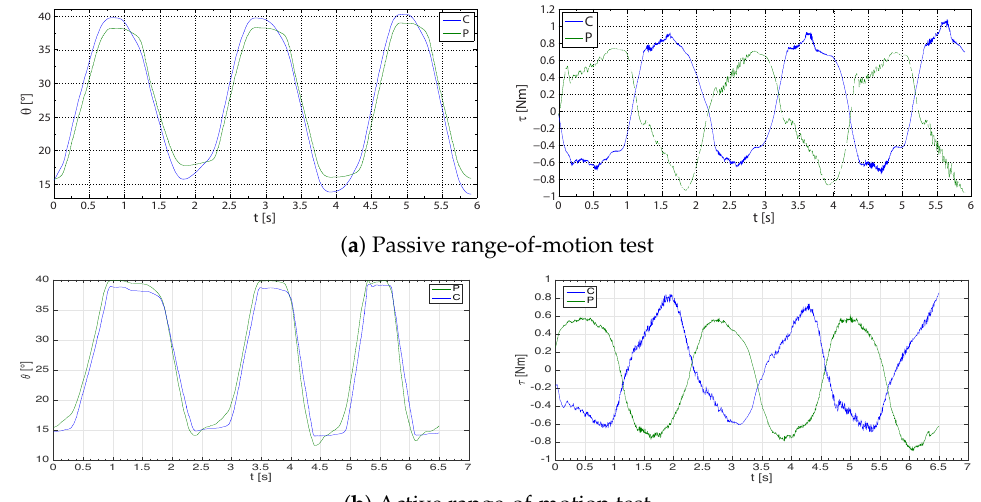
Figure 11. Example of position ( left ) and torque ( right ) tracking performance for the position-force (P-F) two-channel controller operating in contact with a healthy subject during a trial of a passive range-of motion test ( top ) and an active range-of motion test ( bottom ), respectively. τ (Nm) is the torque, positive for the clinician (C, blue) extension and for the subject (P, green) flexion, respectively. θ ( ◦ ) is the angle, which increases with